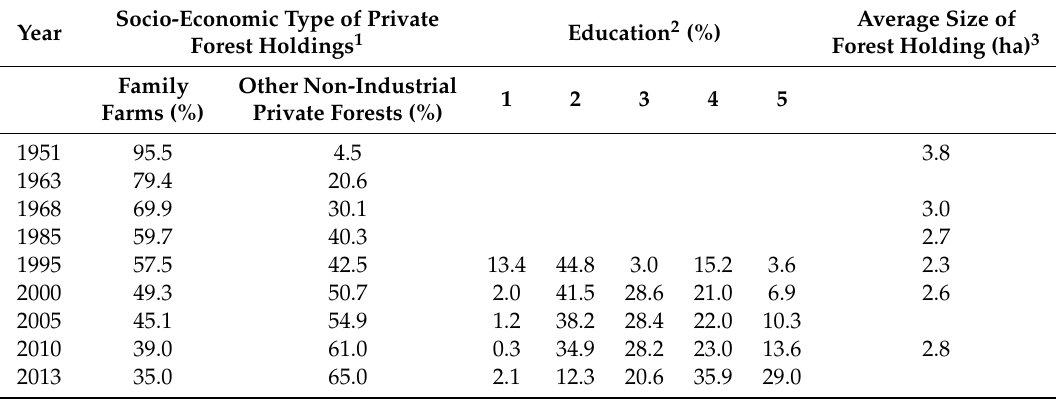
Table 5. Estimates of socio-economic types of private forests, forest owner education, and average size of forest holding in the past